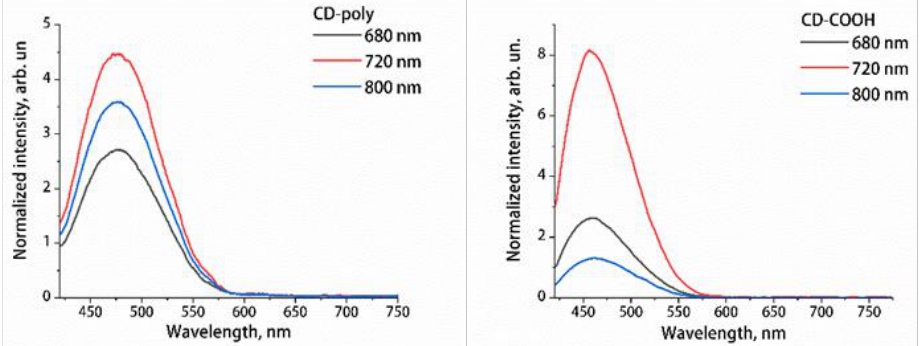
Figure 5. UCL spectra of aqueous solutions of CD-poly and CD-COOH upon excitation by laser radiation at wavelengths of 680, 720, and 800 nm (pH = 11.7).